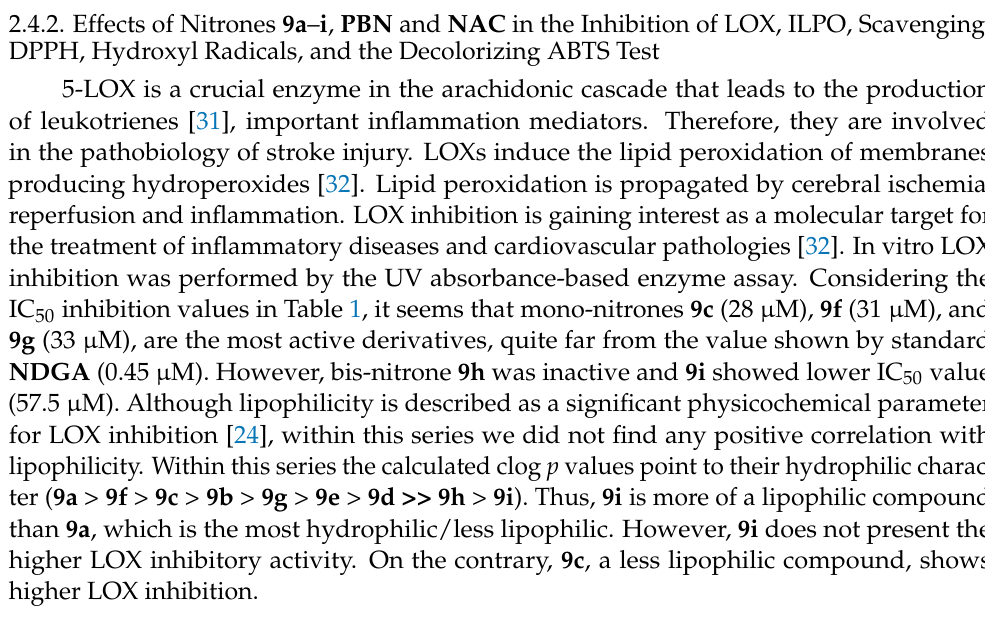
Table 1. In vitro antioxidant activity of nitrones 9a – i a